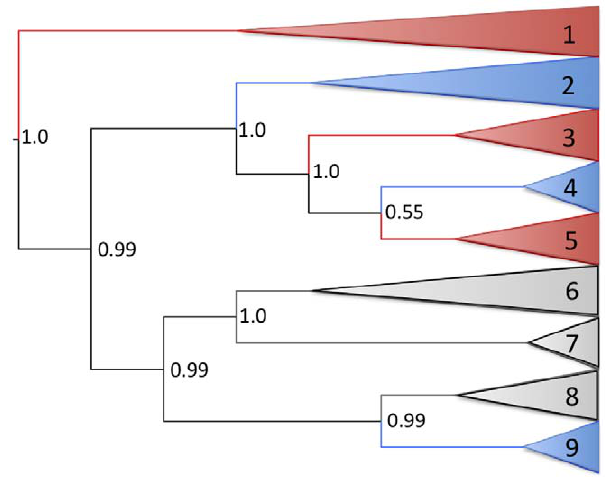
Figure 1. Bayesian partitioned mitogenome phylogeny. Clades are collapsed. Branch colours indicate geographic origin of samples as follows: Antarctic (grey), Atlantic (blue) and Pacific (red). The predominant ecotype or type in each clade is as follows: clade 1: Pacific transient; clade 2: Atlantic haplotypes from the Icelandic and Norwegian herring-eating populations and Gibraltar tuna-eating population; clade 3: Pacific resident; clade 4: Atlantic haplotypes from UK, Canary Islands and Iceland; clade 5: Pacific offshore; clade 6: Antarctic type C; clade 7: Antarctic type B; clade 8: Antarctic type A; clade 9: Atlantic haplotypes from Scotland, Canary Island and Gulf of Mexico. Posterior probabilities are given for nodes of interest. The tree is rooted with long-finned pilot whale (not